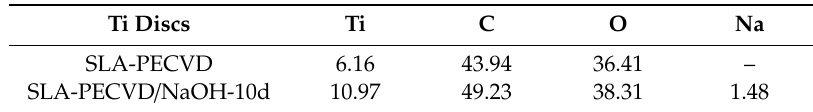
Figure 3. The Ti2 p ( a ), C1 s ( b ), and O1 s ( c ) XPS spectra of the surfaces of the SLA-PECVD and SLA-PECVD/NaOH-10d samples. Table 1. Elemental composition (at.%) determined by XPS analysis of the SLA-PECVD and SLA-PECVD/NaOH-10d samples.